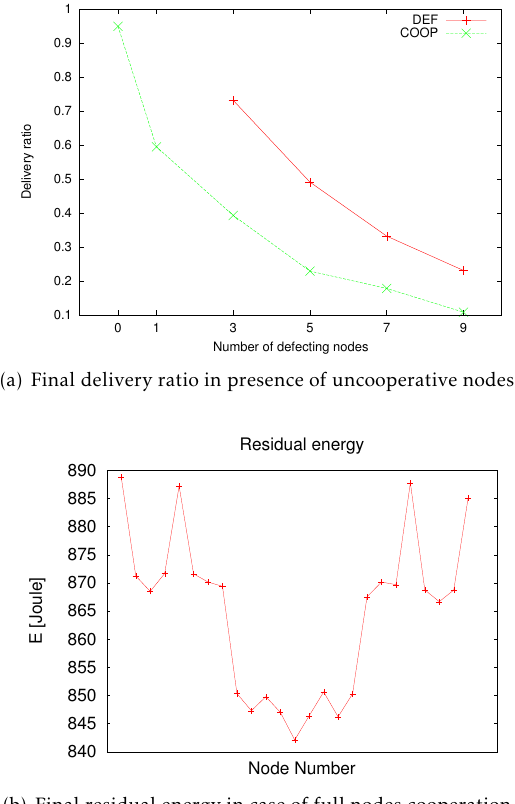
Figure 2. Performance unfairness in a simple 25 nodes